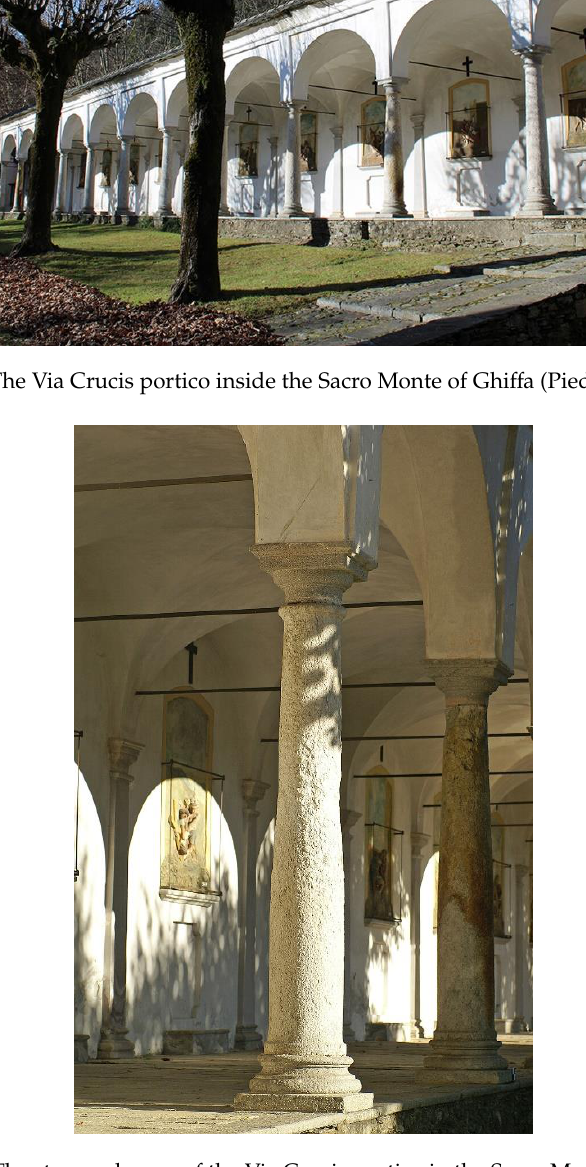
Figure 2. The stone columns of the Via Crucis portico in the Sacro Monte at Ghiffa.